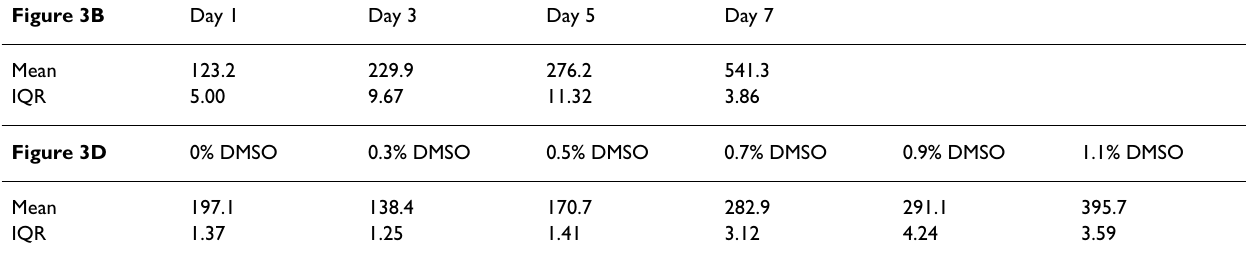
Table 1: Mean and inter-quartile ratio (IQR) of fluorescence intensities for Fig. 3. Figure 3B